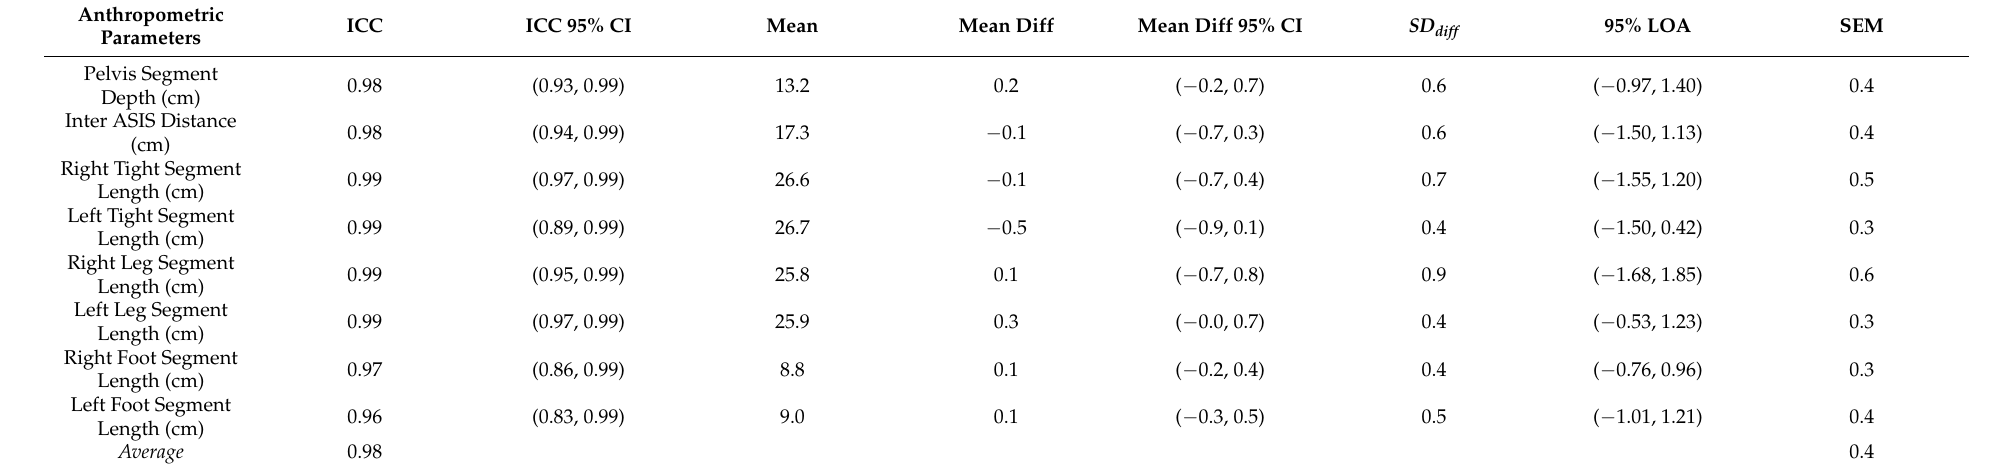
Table 2. Reliability values for anthropometric